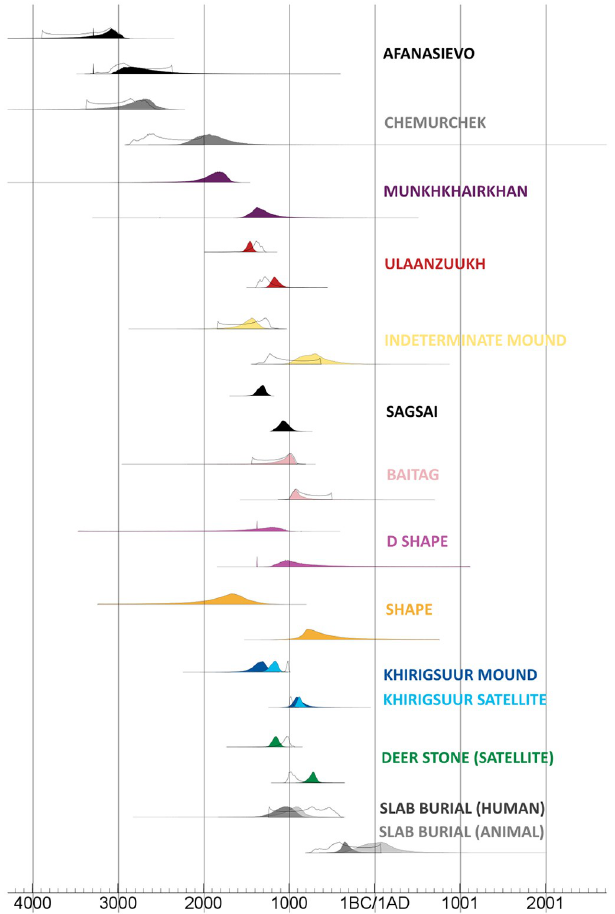
Fig 4. Modeled start boundaries for Bronze and Early Iron Age traditions in Mongolia, showing relative ordering according to posterior results. For each tradition with available data, the quality control-restricted model estimates are provided as an uncolored distribution outlined in